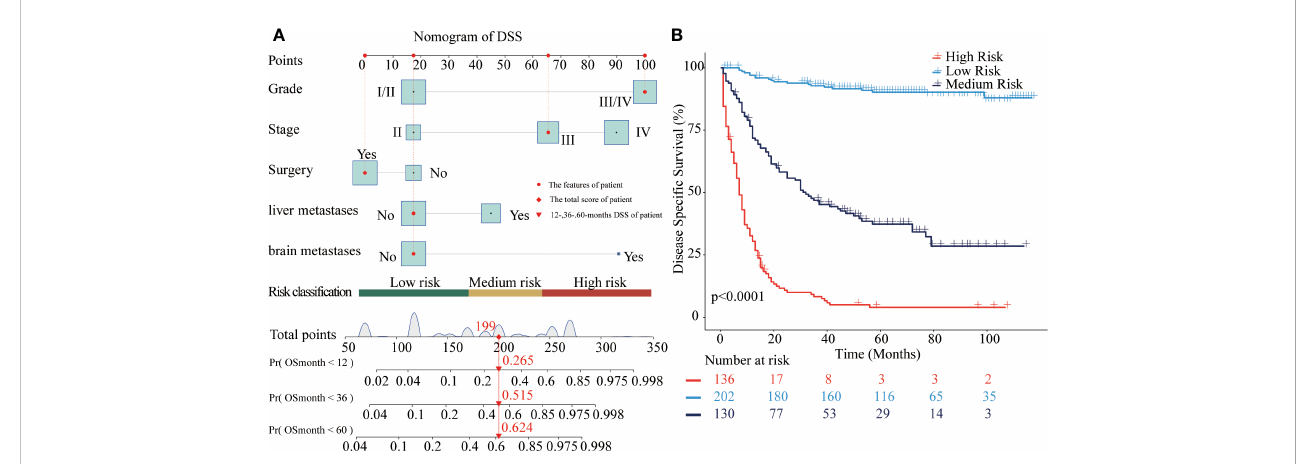
FIGURE 3 Nomograms to predict DSS for patients with CRNENs and risk strati fi cation. (A) nomogram of DSS. (B) the Kaplan-Meier curve of the high-risk, medium- risk, and low-risk groups. CRNENs, colorectal neuroendocrine neoplasms; DSS, disease-speci fi c survival.